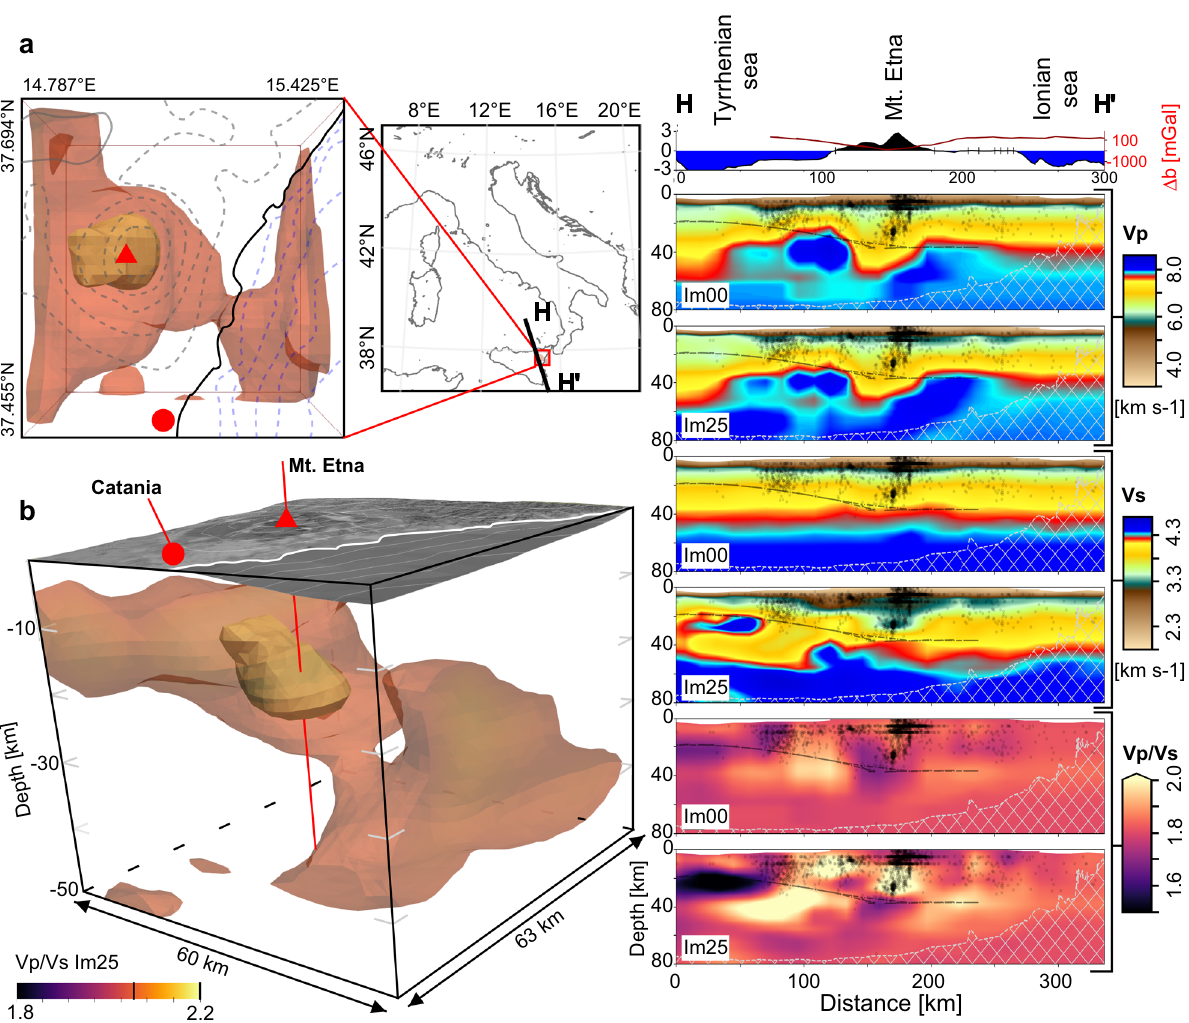
Fig. 3 Vertical cross-sections of models Im00 and Im25 for section HH ’ and 3D visualization of Im25 V p / V s structure under Mt. Etna volcano. The cross-sections are a continuation of Fig. 2 showing section HH' of Figs. 1b, c. The sub- fi gures a , b show a close-up of the area around Mt. Etna volcano (red triangle) in a block of 60 kmx 63 km and 50 km depth. In ( a ) the block is seen from the top and in ( b ) in a 3D view; black segment in the map is the trace of the section on the right; black or white lines denote the Sicilian coast in the two sub- fi gures, respectively. Isovolumes represent the V p / V s Im25 model inside the block with orange denoting V p / V s = 1.95 and dark yellow denoting V p / V s = 2.2. A shallow, high V p / V s feature (2.2) is imaged right below the volcano and another high V p / V s isovolume (1.95) deepens southeastward below the Malta